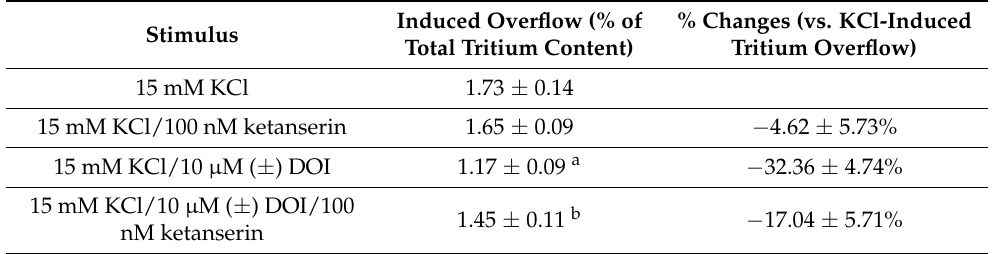
KCl/100 nM MDL11,939: 1.77 ± 0.08, n = 5; n.s. )